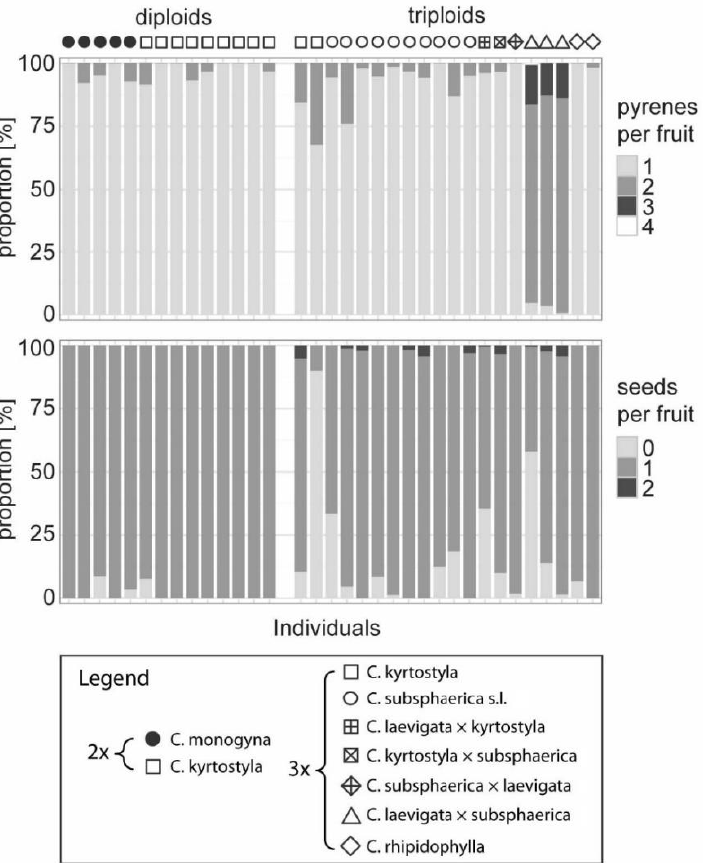
Figure 2. Fruit characteristics of diploid and triploid individuals. Number of pyrenes (upper panel) and well developed and healthy seeds (lower panel) per fruit expressed as percentage data for 14 diploid and 20 triploid